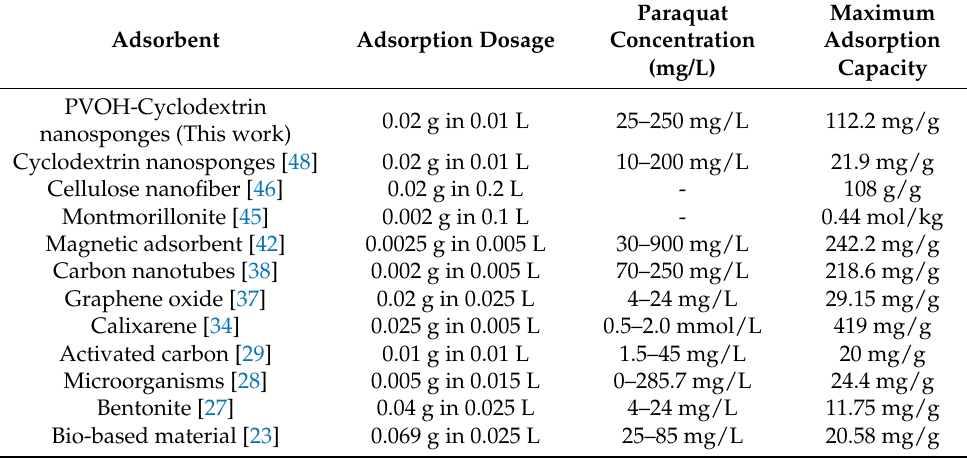
Table 4. Langmuir isotherm for paraquat removal by various adsorbents.